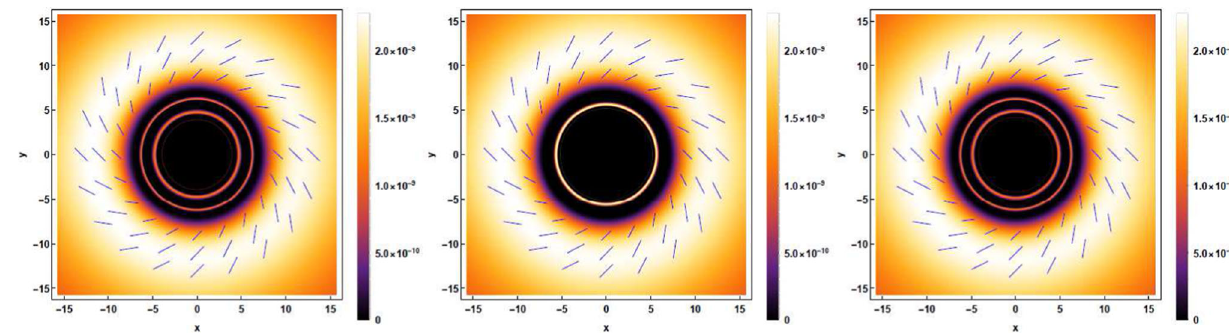
Fig. 8 Polarized intensity tick plots in the direct image for the fixed θ o = 0 ◦ . The coupling parameter α in three panels from left to right is set to − 0 . 4, 0, and 0 . 4, respectively. Here, we set M = 1